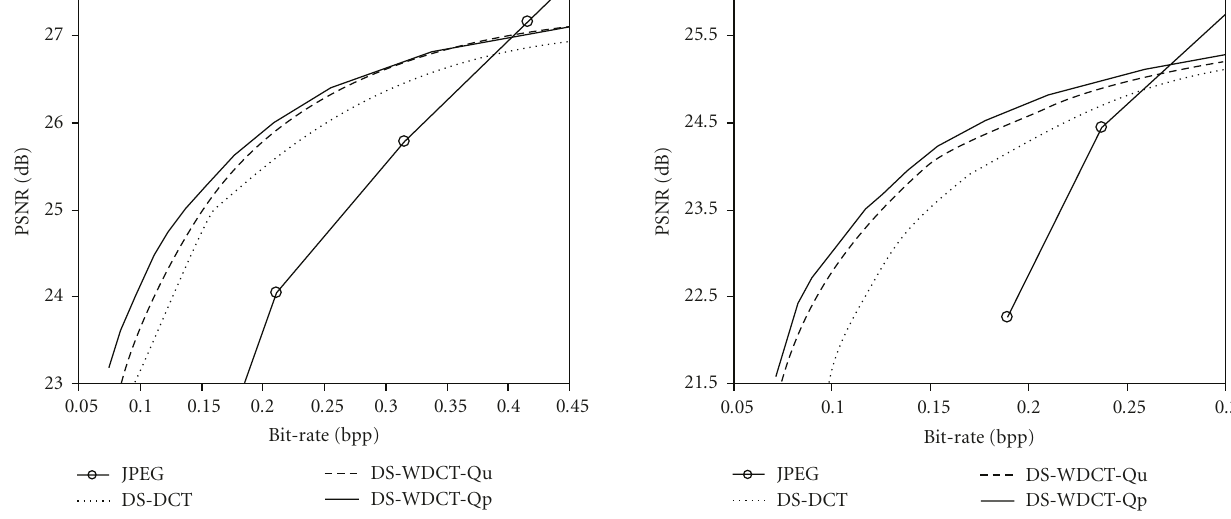
Figure 5: PSNR versus bit-rate for the Cameraman image of size 256 ×